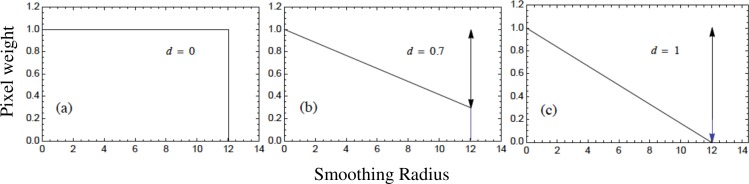
Smoothing kernels with varying decay.(A) A flat smoothing kernel, where all pixels within the radius are averaged equally. (B–C) Decaying smoothing kernels, where pixels closest to the central pixel are weighted more heavily in the average than pixels that are farther away.